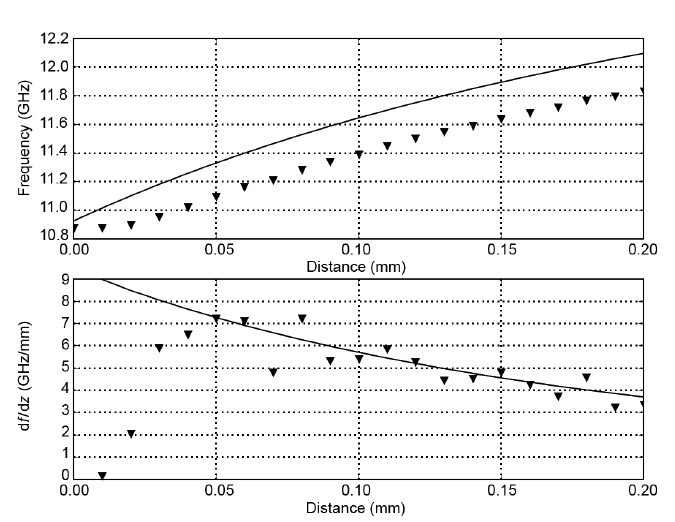
Fig. 6. Resonance frequency and tuning coefficient of the E 11,1,1 mode in function of the distance between the two disk of 42 mm diameter and 5 mm height (points-experimental values; line-theoretical